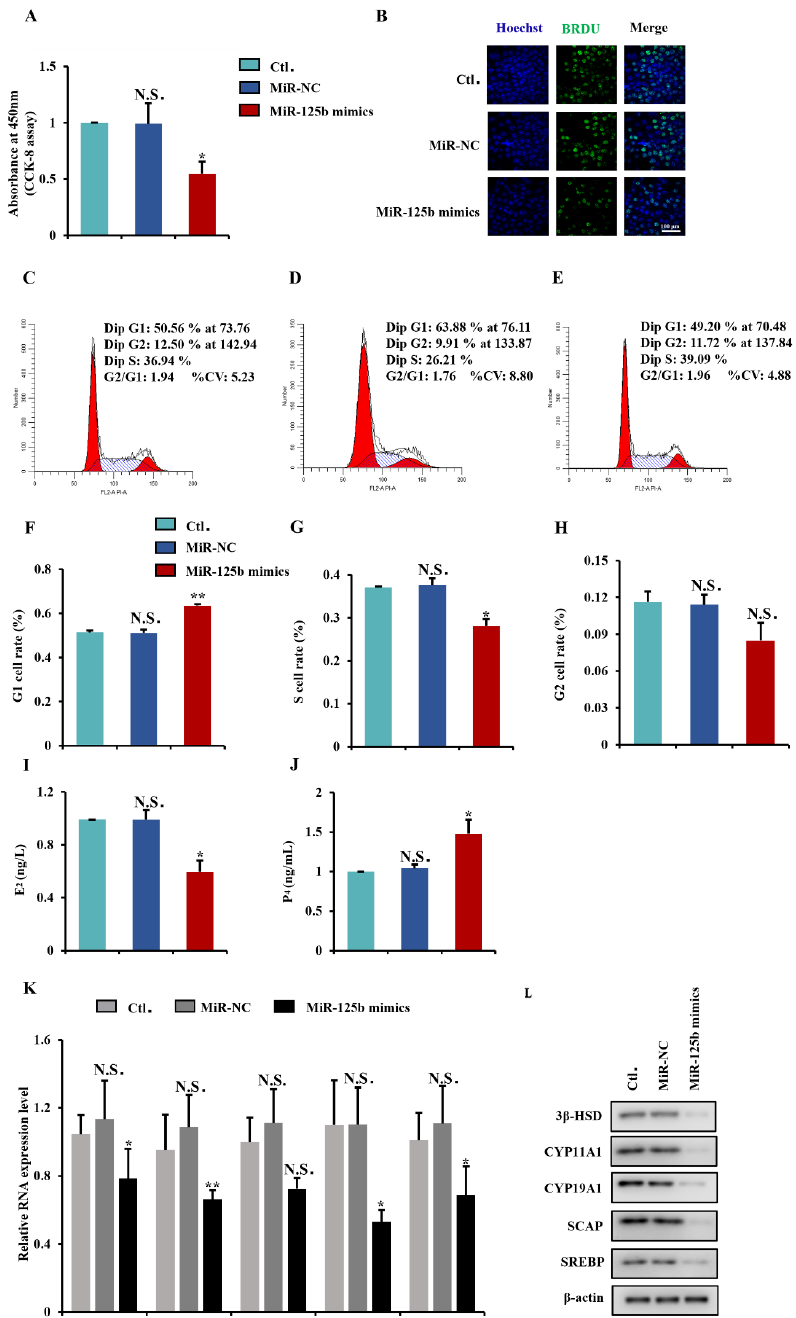
Figure 5. MiR-125b inhibit GCs steroidogenesis and proliferation. ( A ) The cell counting kit-8 (CCK-8) assay of GCs at 48 h after transfection of MiR-125b mimics and MiR-NC. ( B ) BrdU analysis was performed to assess the effect of MiR-125b overexpression on GCs proliferation. ( C – H ) Cell cycle analysis of GCs at 48 h after transfection of MiR-125b mimics plasmid. ( I ) Determination of E 2 concen- trations after 48 h of GCs transfected with MiR-125b mimics. ( J ) Determination of P 4 concentrations after 48 h of GCs transfected with MiR-125b mimics. ( K ) The qRT-PCR of relative expression levels of steroidogenesis-related (CYP11A1, CYP19A1, and 3 β -HSD) and sterol regulation-related (SCAP and SREBP) mRNAs in GCs transfected with MiR-125b mimics. ( L ) Overexpression of MiR-125b affected the expression of steroidogenesis-related proteins and sterol regulatory element proteins. Values represent means ± SEM for three individuals. * p < 0.05; ** p < 0.01. N.S., not